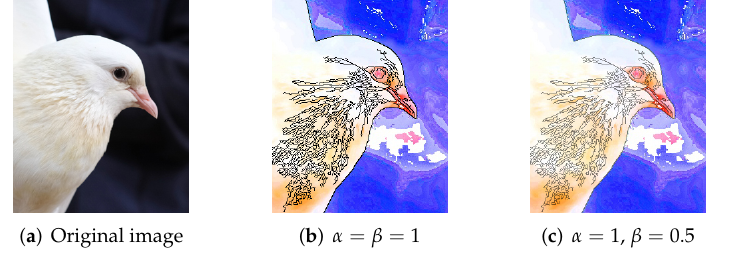
Figure 7. Enhanced images generated with different